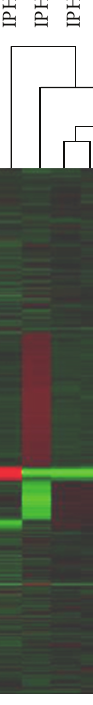
Figure1:Resultsofclusteranalysisofgeneexpressiondata.Thedark purple to red regions indicate relative increases in expression, while the dark green to yellow-green regions indicate relative decreases in expression. There were no dominant increases/decreases in gene expression in the IPH group as compared to the healthy control